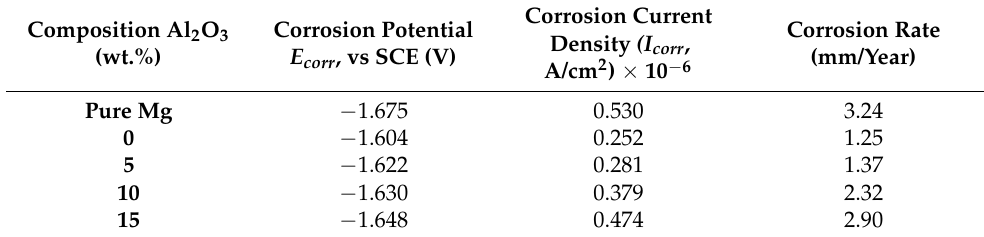
Table 4. Electrochemical profile for the Mg-Zn/HAP/Al 2 O 3